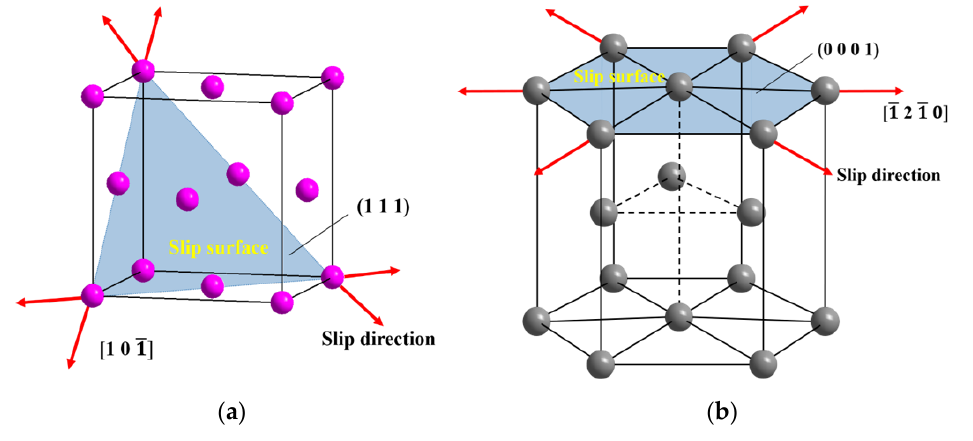
Figure 4. Lattice slip system of ( a ) Al and ( b ) Ti.